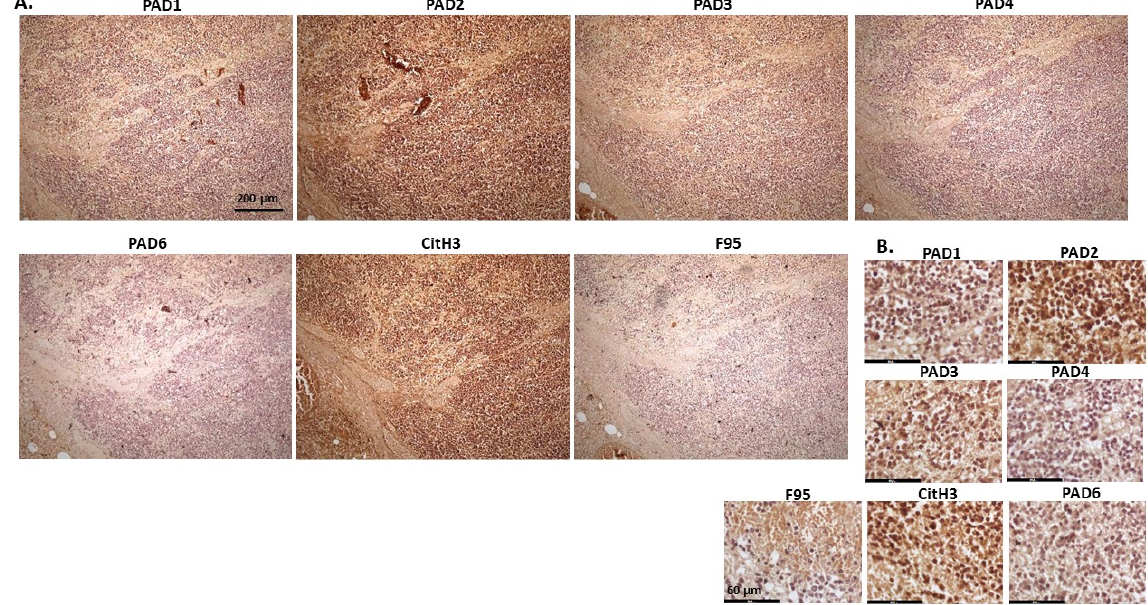
Figure 6. Mink, malignant renal tumour (possibly nephroblastoma). Cadaver, adult mink, male. Tumour in kidney with metastasis to lung and liver. ( A ) Overview images for PAD1, 2, 3, 4, 6, CitH3, and F95 stainings of serial tissue sections; scale bar represents 200 μ m for all images; 10× objective. ( B ) Higher magnification shown for each staining from the images in A; scale bar repre- sents 60 μ m for all images; 40× objective.